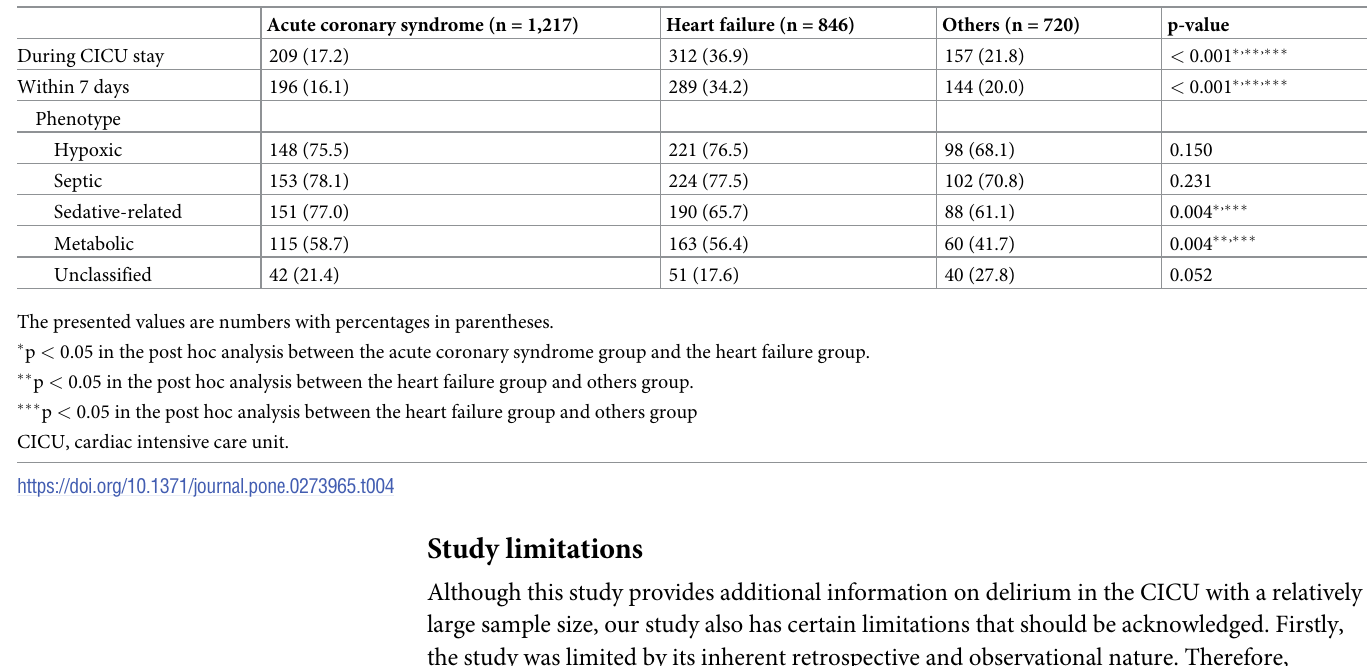
Table 4. Prevalence of delirium phenotypes according to primary diagnosis.